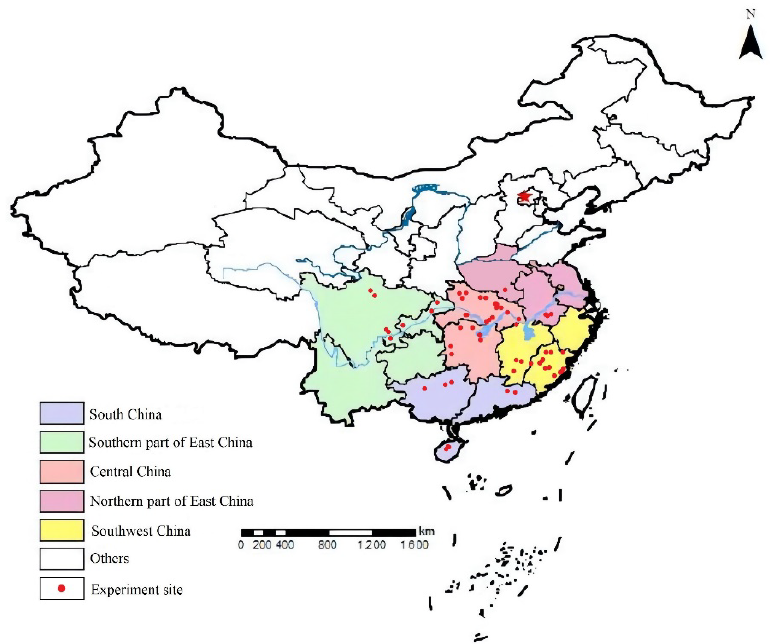
indicates Beijing. Figure 1. Experiment sites and main regions for RR cultivation in China. (cid:70) indicates ★